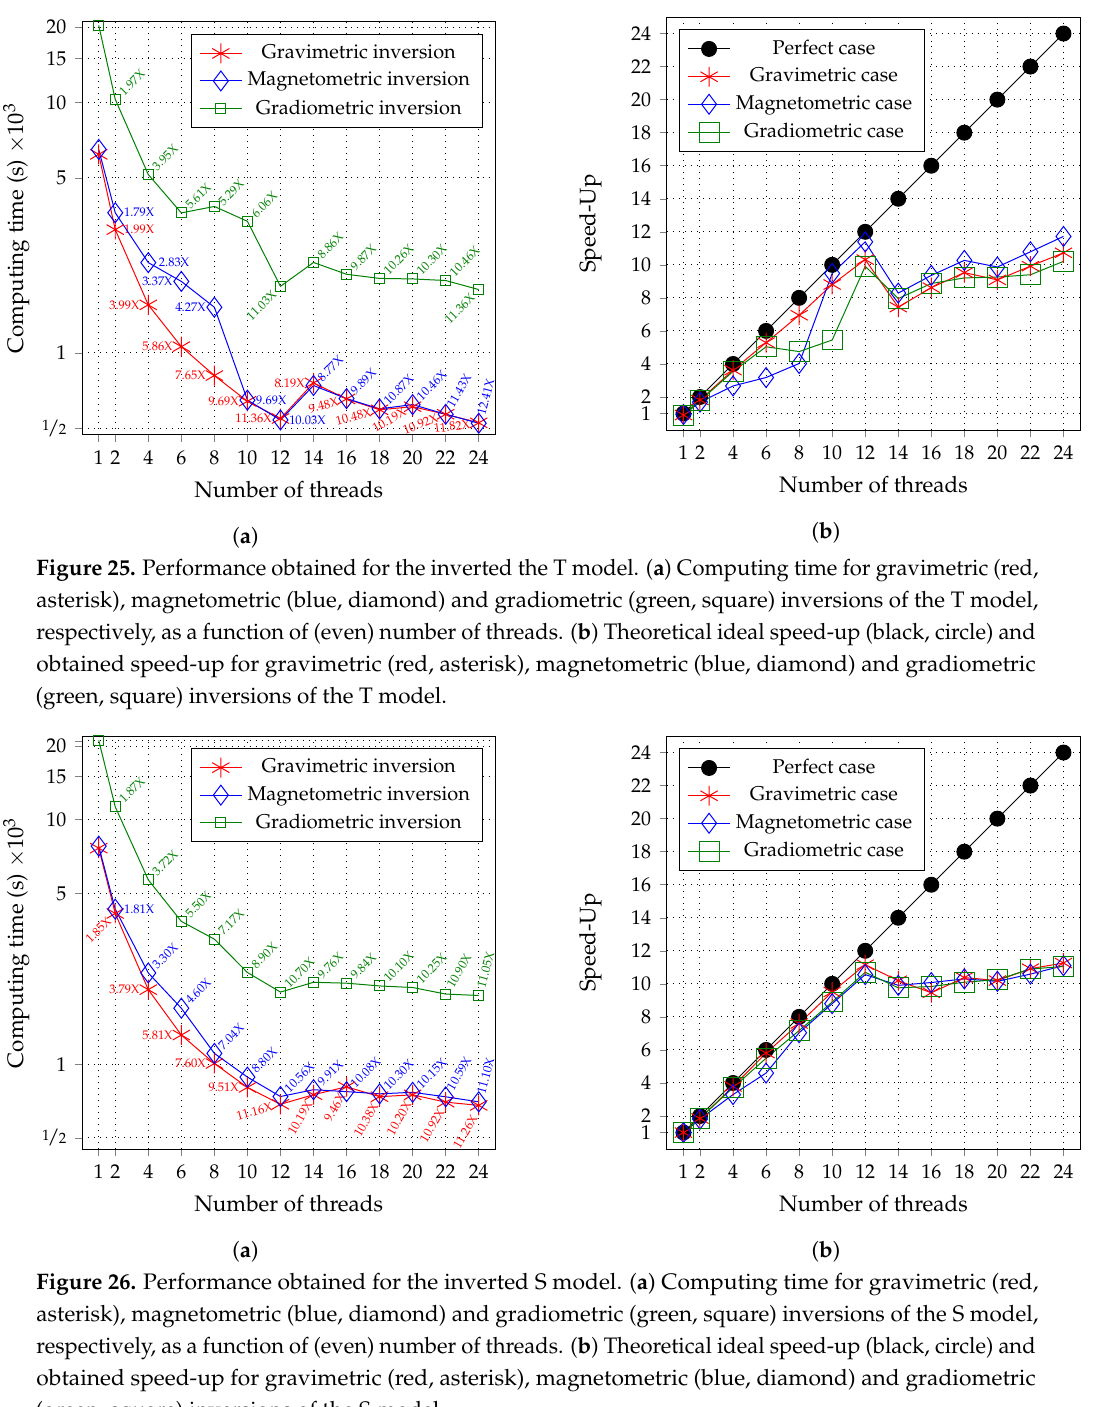
Figure 26. Performance obtained for the inverted S model. ( a ) Computing time for gravimetric (red, asterisk), magnetometric (blue, diamond) and gradiometric (green, square) inversions of the S model, respectively, as a function of (even) number of threads. ( b ) Theoretical ideal speed-up (black, circle) and obtained speed-up for gravimetric (red, asterisk), magnetometric (blue, diamond) and gradiometric (green, square) inversions of the S